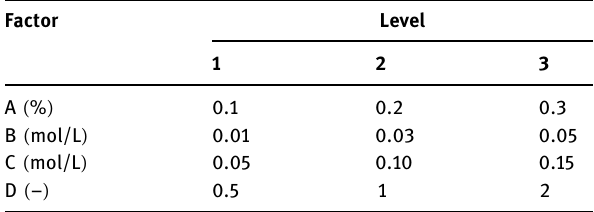
Table 1: Factors and levels for the experimental design